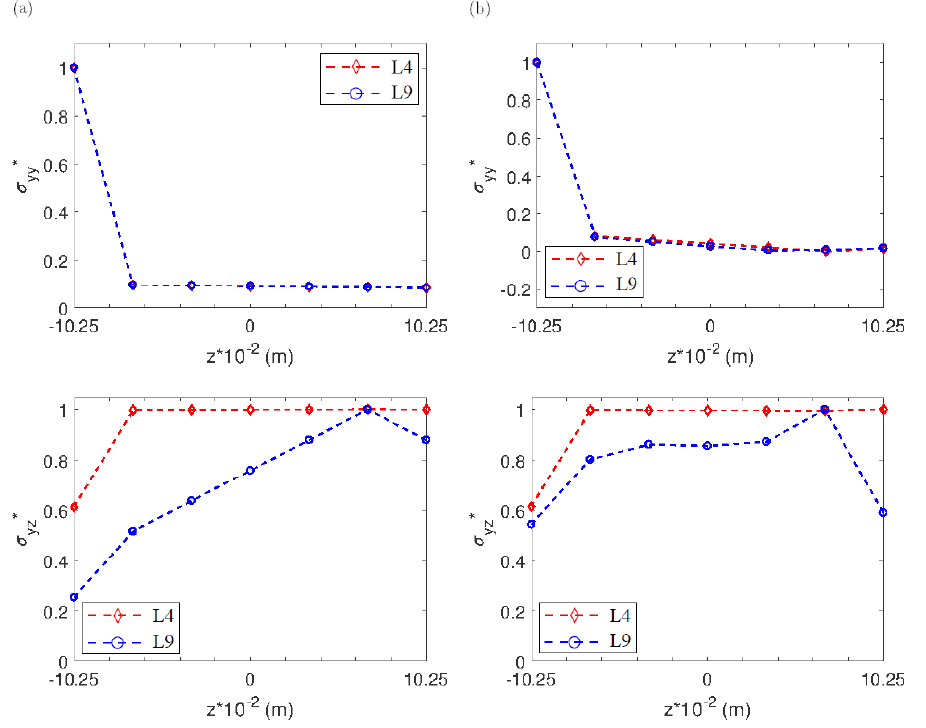
Figure 7. Distribution of axial and shear stress components for ( a ) P ∗ = − 3.3 − 4 and ( b ) P ∗ = − 2.95 − 3 loads in NL regime at L4 and L9 extensions at x = − a 2 /2 and y = L /2 in the single-cell composite